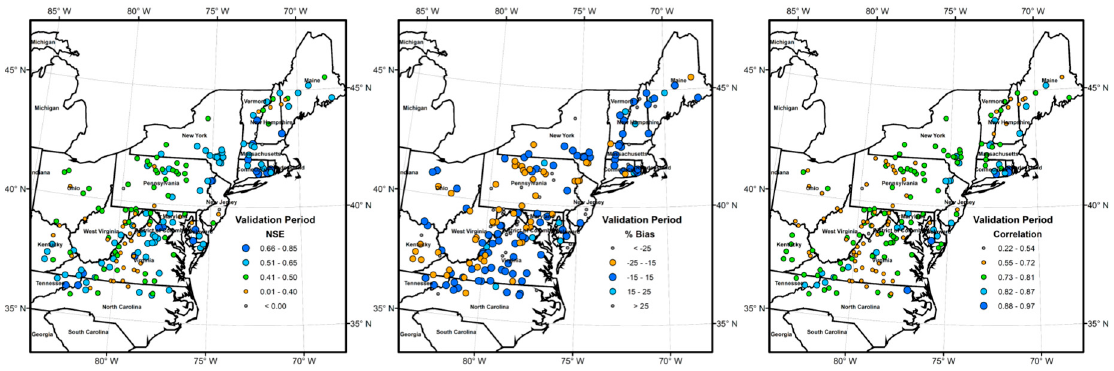
Figure 4. Nash Sutcliffe efficiency, percentage bias and correlation of smoothed daily streamflow for the validation period of 1981–1990.